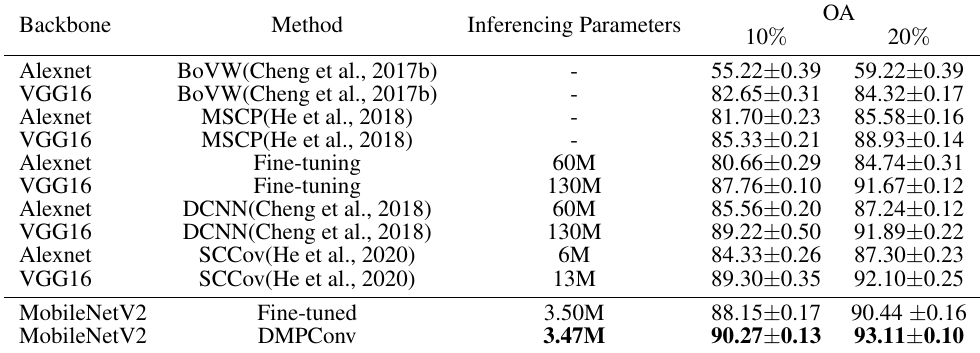
Table 4. Comparison of OAs (%) obtained on the NWPU-RESISC45 data set.